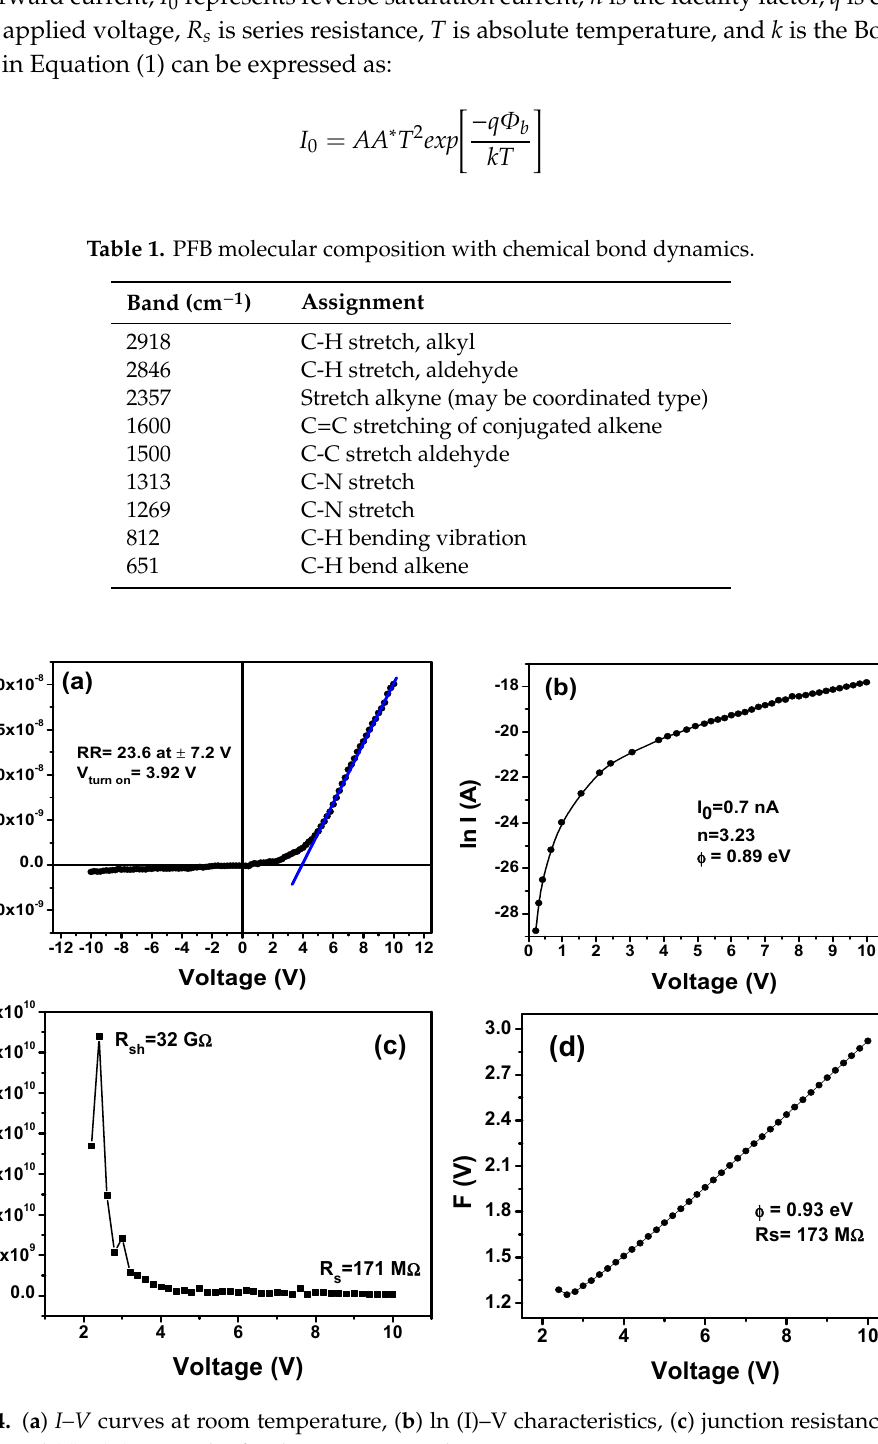
Table 1. PFB molecular composition with chemical bond dynamics.